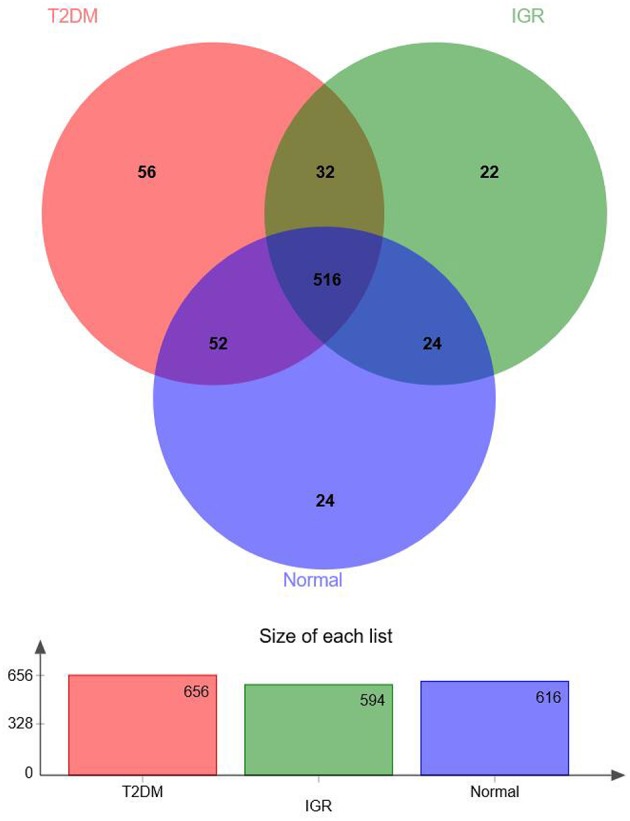
Venn map of OTUs.